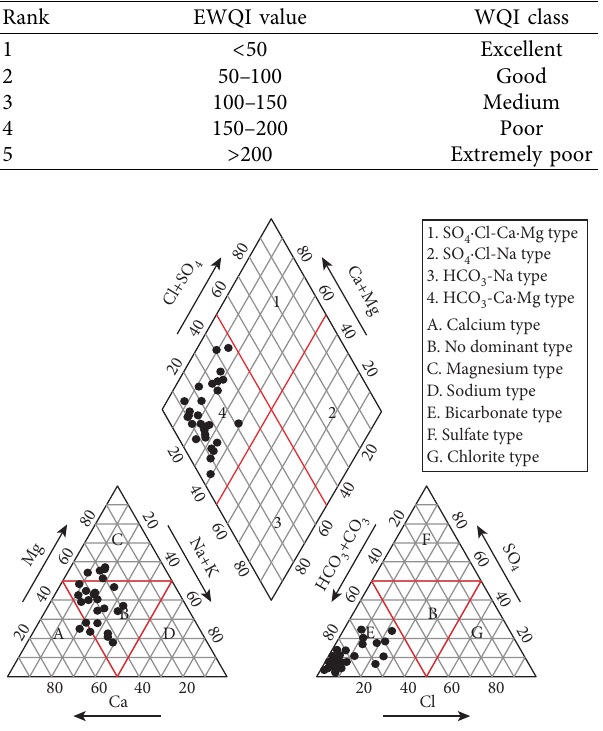
Figure 2: Piper map of the shallow